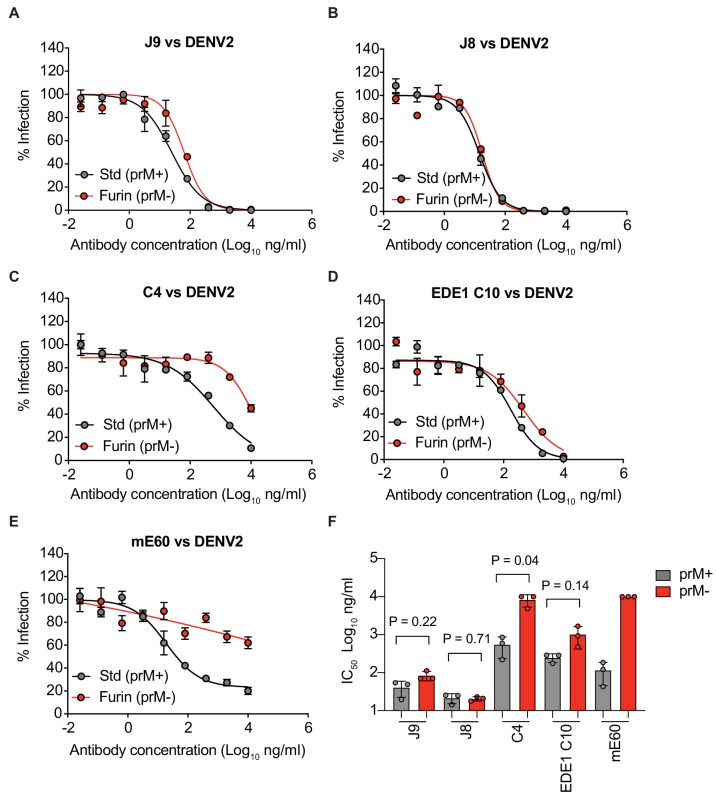
Antibody neutralization of standard and mature reporter virus preparations.(A) Dose-response neutralization curves for the indicated antibodies against DENV2 reporter virus prepared under standard conditions (Std) or in the presence of overexpressed furin to generate mature (Furin) virus particles. Data points and error bars indicate the mean and range of infectivity in duplicate wells, respectively. (B) Mean IC50 values of antibodies against standard or mature reporter viruses from three independent experiments depicted by data points. Error bars indicate the SD. P-values were obtained from two-tailed paired t-tests.